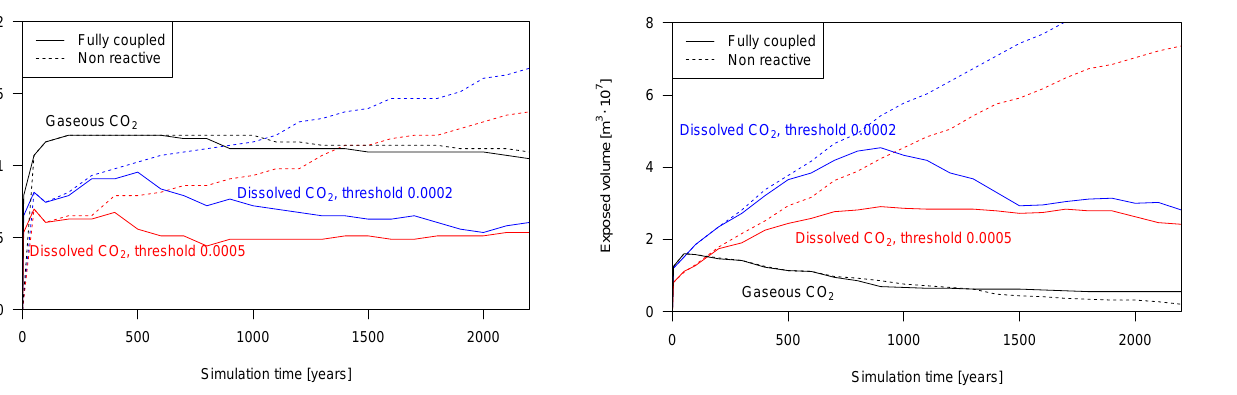
Figure 5. Heterogeneous simulations: reservoir volume exposed to gaseous and dissolved CO 2